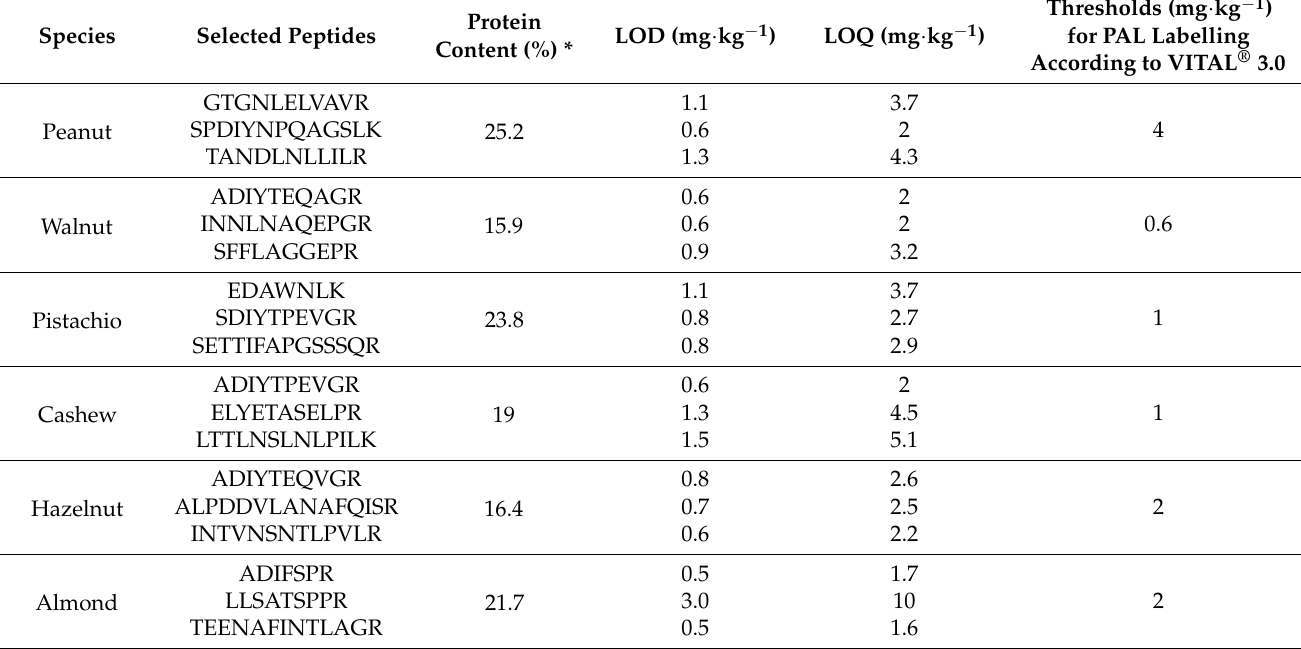
Table 6. LOQ and LOD values, expressed as mg of total proteins per kg of cookie (mg · kg − 1 ), achieved with the method developed during this study. The values were obtained from LOD and LOQ values reported in Table 4 (mg of allergenic ingredient per kg of cookie) after considering data on the total protein content of each ingredient. For the sake of comparison, threshold levels inferred for each species from the VITAL ® program, based on the ED01 eliciting dose and referred to a 50 g portion, are reported in the last column. See text for